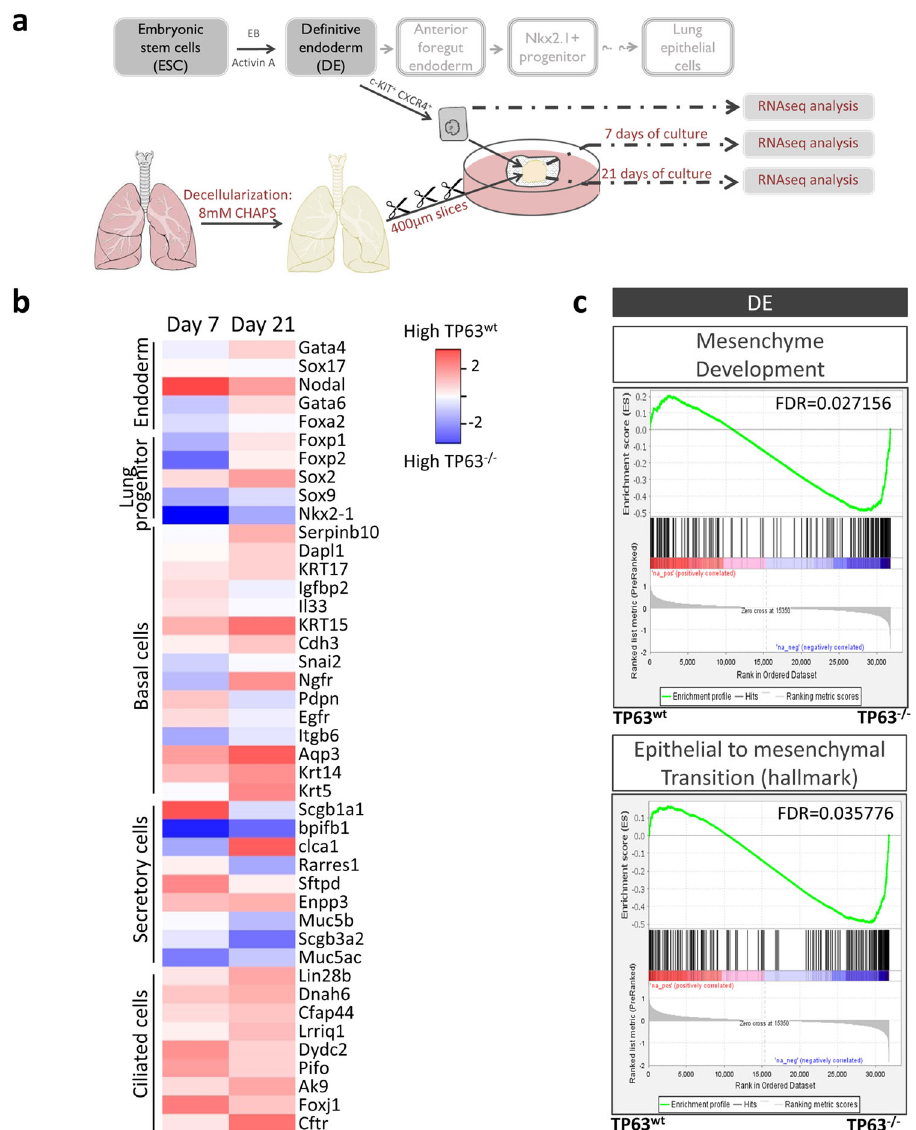
Fig. 6 Transcriptome pro fi ling of wildtype and TP63-de fi cient de fi nitive endoderm (DE) cells seeded on decellularized lung scaffolds. a Schematic of RNA-seq experiments. b Heat map of genes predominantly associated with endoderm, lung progenitor, basal and proximal (secretory and ciliated) airway cells, respectively; columns show averaged log expression between TP63 wt and TRP63 − / − DE-scaffolds per time point. c GSEA of DE cells for gene sets related to mesenchyme development and epithelial to mesenchymal transition in TP63 − / − DE cells compared to wildtype DE cells. RNA sequencing was repeated 4 times using 4 separate wildtype and 3 separate TP63-de fi cient DE cell-scaffold cultures. Averaged fold change in ( b ) is expressed as